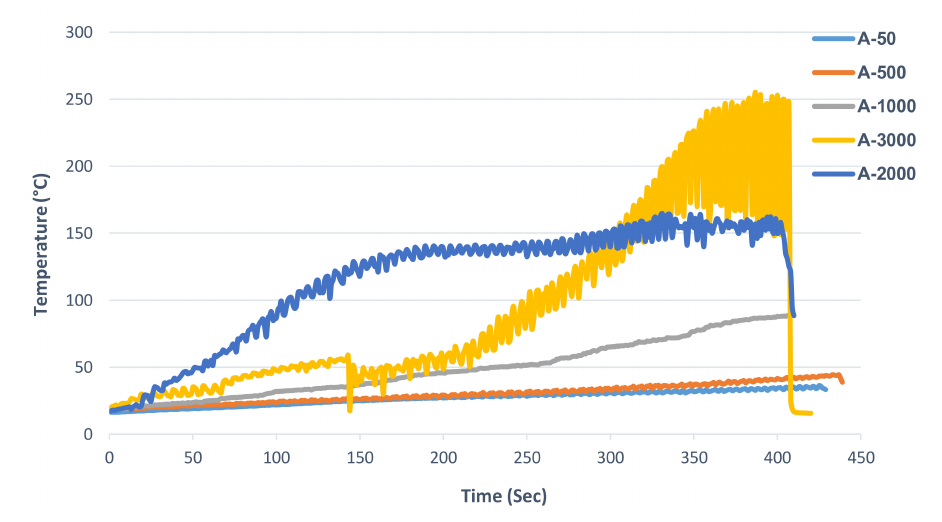
Figure 6. Temperature profiles at varying rotational speed, as observed during ISF of annealed AA-2219